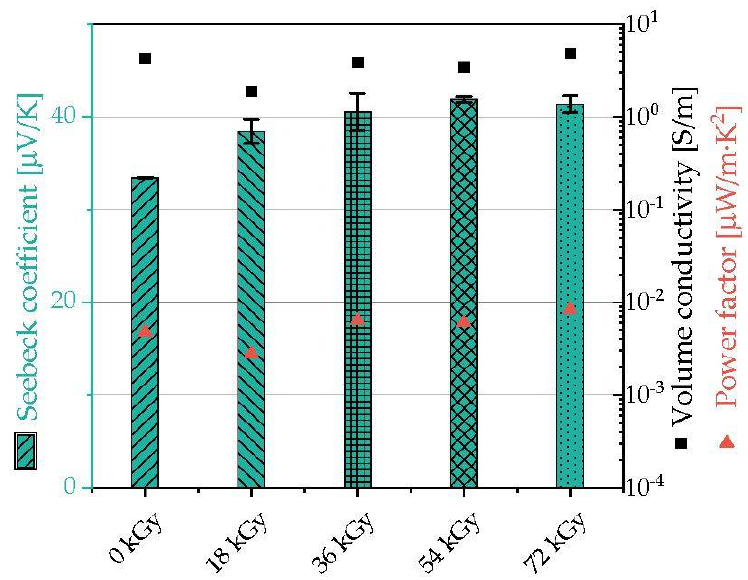
Figure 11. Seebeck coefficient, volume conductivity and power factor of PP/1 wt.% SWCNT composites (obtained by masterbatch dilution) irradiated at 40 °C with different doses. Table 6. Thermoelectric parameters of PP/1 wt.% SWCNT composites irradiated at 40 ◦ C with different doses shown in Figure